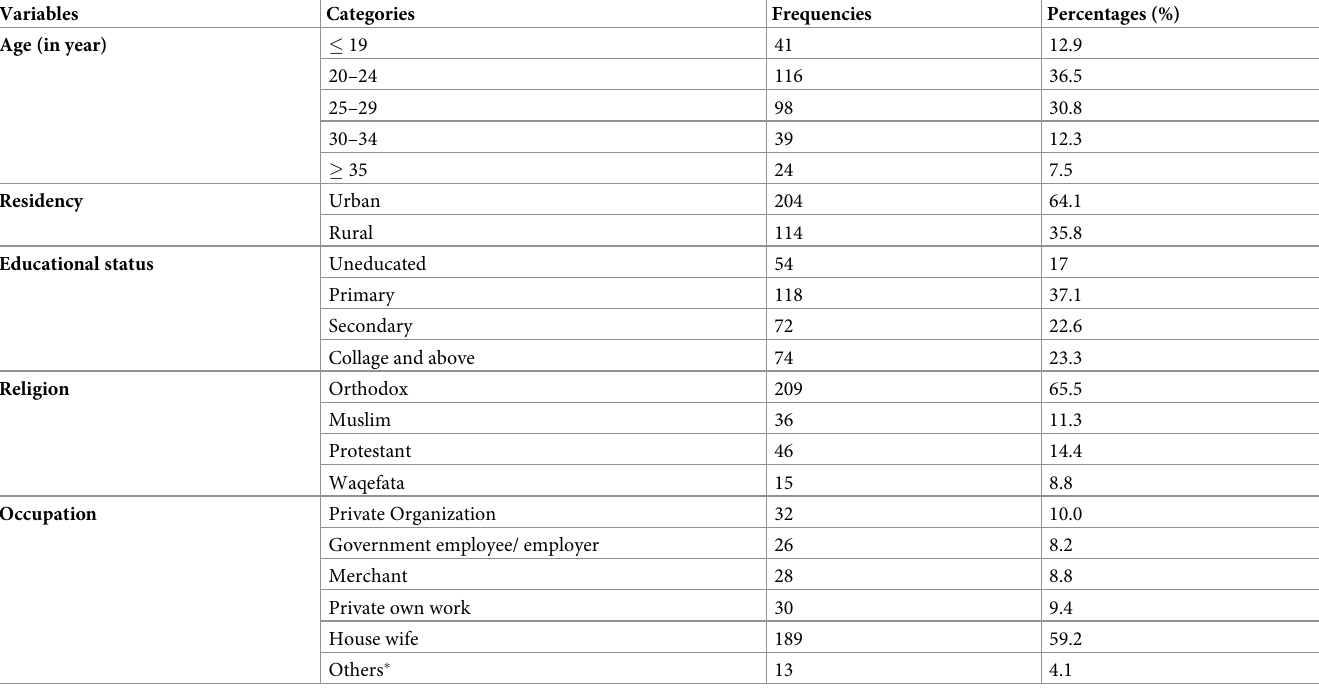
Table 1. Socio-demographic characteristics of women who gave birth at public health facilities in Mojo town, Central Ethiopia, 2019 (n =